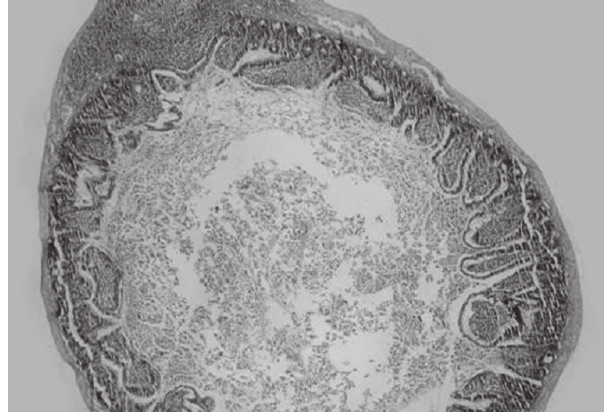
Figure 2 - Histological appearance of the I/R group. Villous epithelial separation, luminal epithelial seeding and naked subepithelial areas (H&E x100).